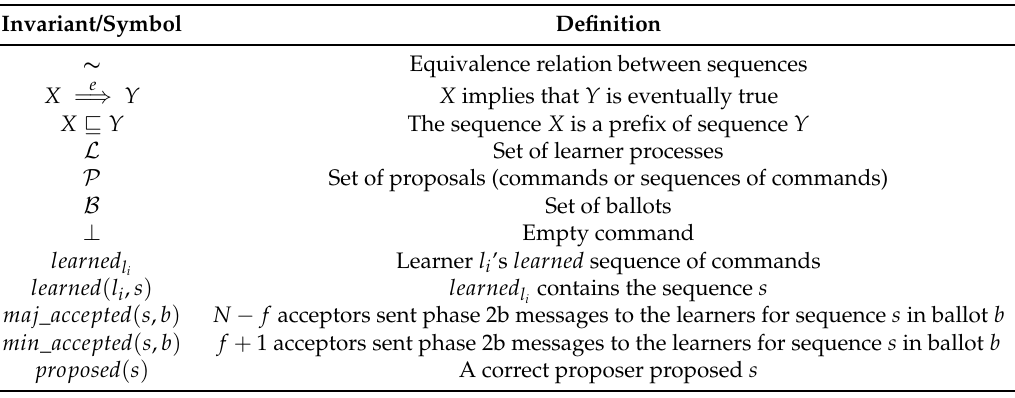
Table 1. BGP proof